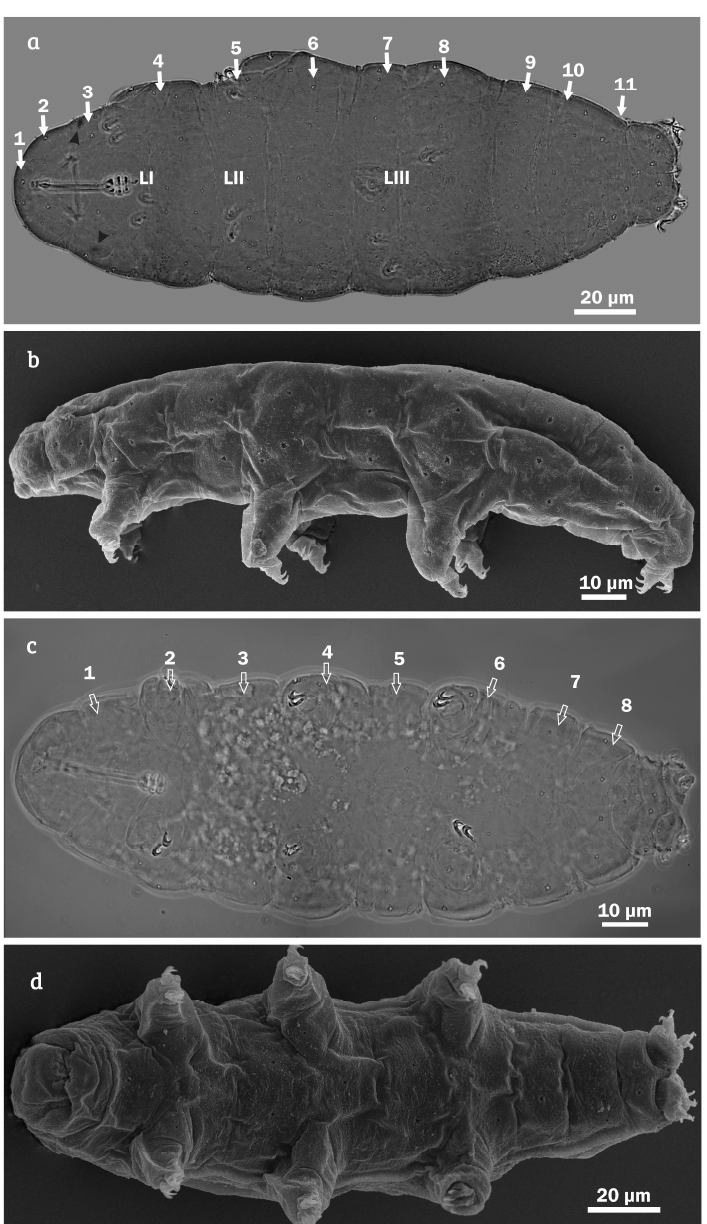
Figure 4. Minibiotus citlalium sp. nov. habitus. ( a ) Dorsal view, showing 11 transverse rows of pores (holotype, PCM), full arrows indicate the 11 transverse rows of pores (dorsal view); LI leg I, LII leg II, LIII leg III, black arrowhead indicate eyes spots; ( b ) lateral view (SEM); ( c ) ventral view, showing eight transverse rows of pores (holotype, PCM), empty arrows indicate the eight transverse rows of pores (ventral view); and ( d ) ventral view (SEM).